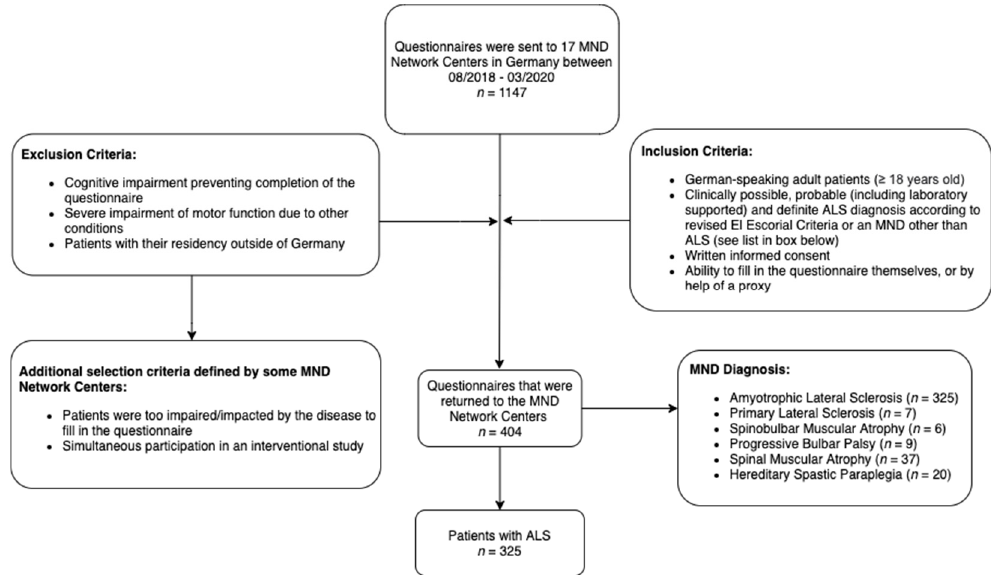
Figure 1. Flow chart diagram depicting identification of the final study cohort and inclusion and exclusion criteria. Abbreviations: ALS, Amyotrophic Lateral Sclerosis; MND, Motor Neuron Disease; n , number.